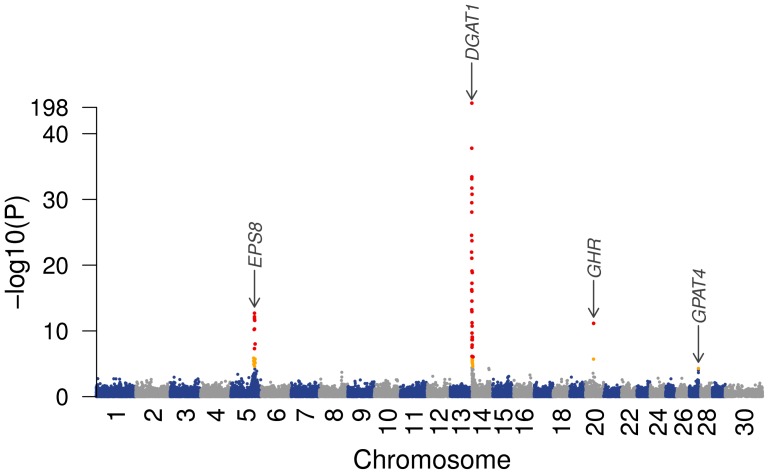
Association of 44,280 SNPs with the estimated breeding values for milk fat percentage in 2327 animals of the German Holstein-Friesian population.Red symbols represent SNPs with P<1.3×10−6 (Bonferroni-corrected significance level), orange symbols indicate chromosome-wide significance.